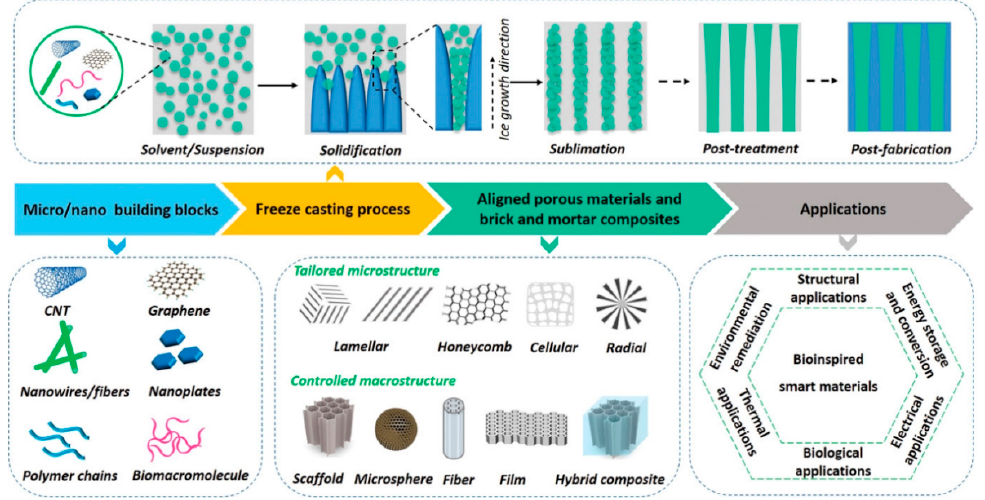
Figure 4. Schematic diagram of the themes discussed in this review, from the macroscopic assembly of micro/nano building blocks to emerging applications, Reproduced with permission from reference [42].